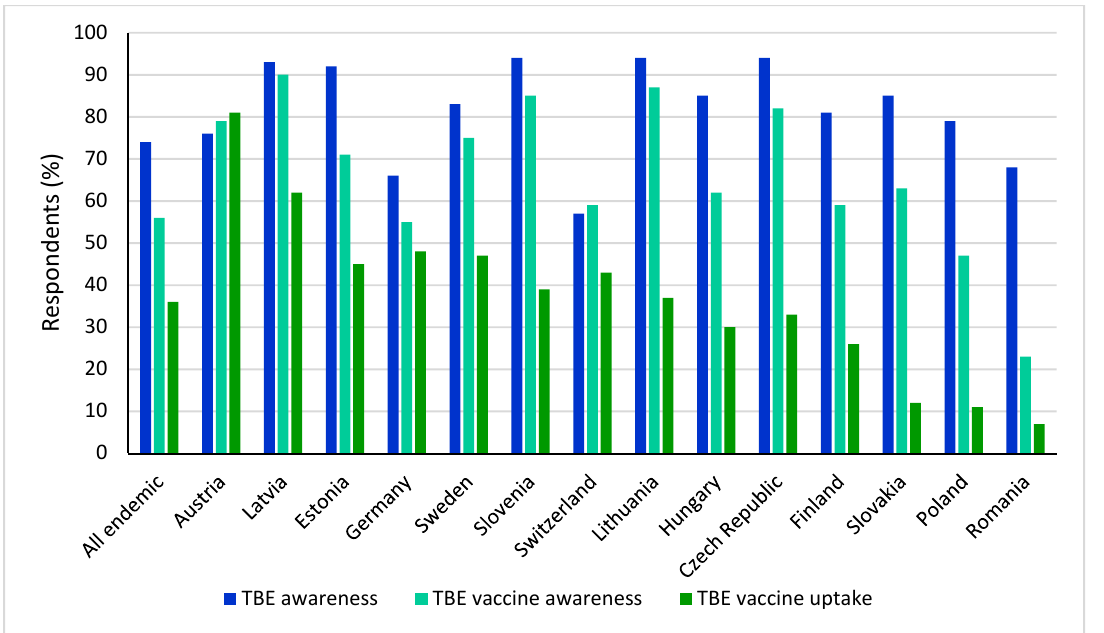
Figure 4. TBE disease awareness, vaccine awareness, and self-reported vaccination rate overall and across endemic countries.